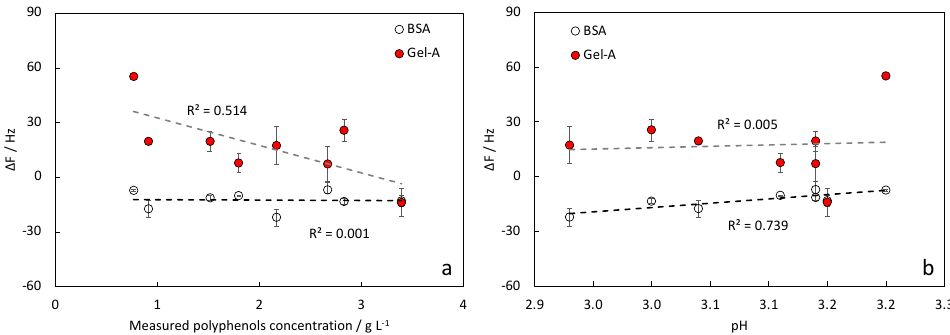
Figure 7. Detection of polyphenols in samples with gallic tannins added (samples G and H, Table 2): ( a ) as a function of measured polyphenols concentration, ( b ) as a function of measured pH.